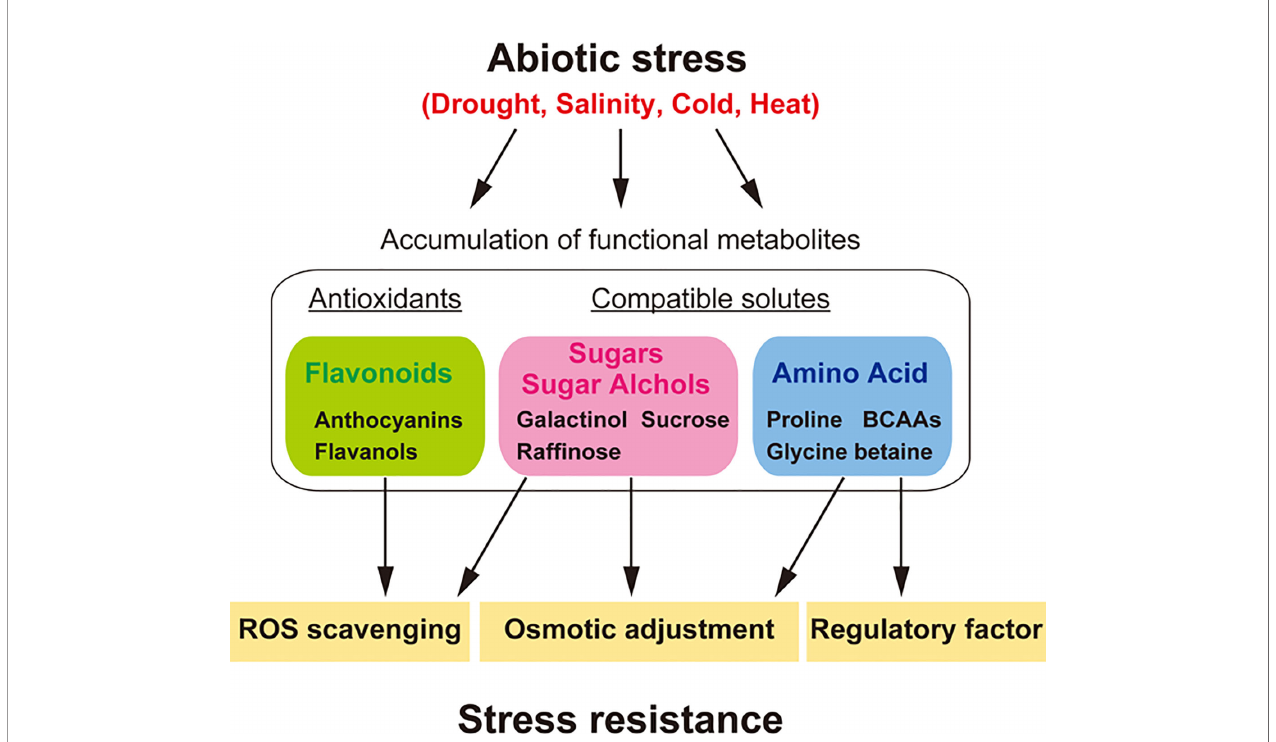
FIGURE 2 | Metabolites and their functions in abiotic stress tolerance, especially under drought, salinity, cold and heat stress. Plants show a variety of metabolic responses to diverse abiotic stresses. Stress-induced accumulation of compatible solutes such as sugars (e.g., raf fi nose and sucrose), sugar alcohols (e.g., galactinol), and amino acids (e.g., BCAAs, proline, and glycine-betaine) functions in osmotic adjustment, enabling the maintenance of cell turgor for plant growth and survival under stress conditions. These compatible solutes, especially galactinol and raf fi nose, can act as free radical (ROS) scavengers, protecting against oxidation by removing excess ROS and reestablishing the cellular redox balance. BCAAs can act as regulatory factors in the production of specialized/secondary metabolites as a defense response against biotic stress during abiotic stress. Stress-induced accumulation of antioxidants such as fl avonoids (e.g., anthocyanins and fl avonols) allows them to act as free radical scavengers to mitigate oxidative and drought stress in plants. Genes involved in metabolite synthesis in diverse abiotic stress responses are useful for application in the metabolic engineering of stress resistance in dry fi eld